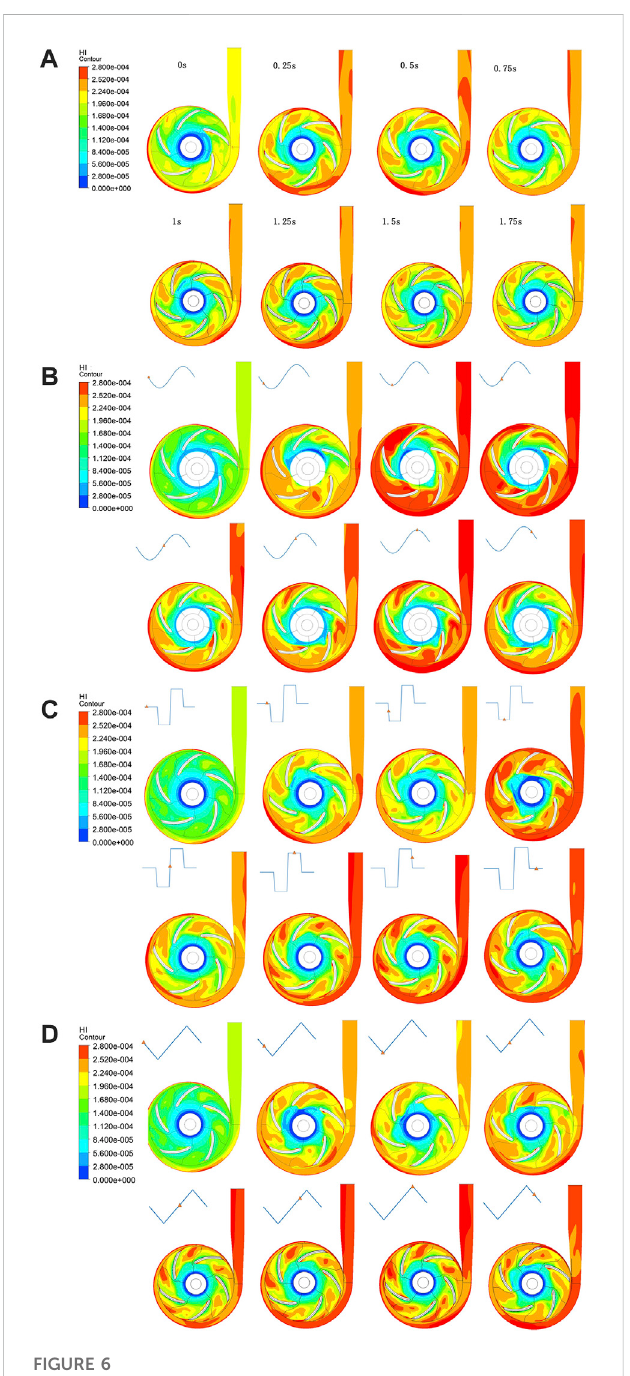
Time – course contour maps of the HI distribution on the radial cut plane of the pump under (A) constant, (B) sinusoidal, (C) square, and (D) triangular speed modulation conditions.